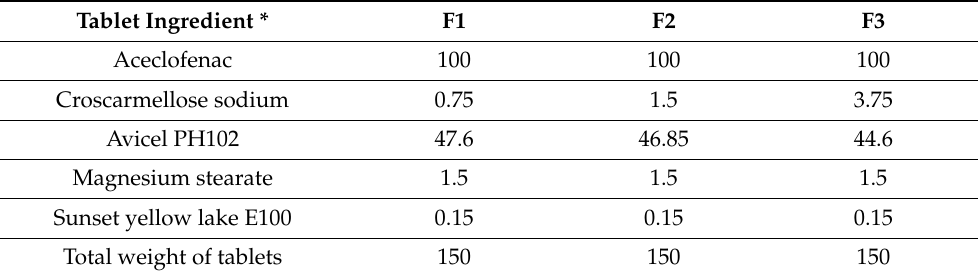
Table 12. The formulations of the core tablets (F1, F2, and F3).